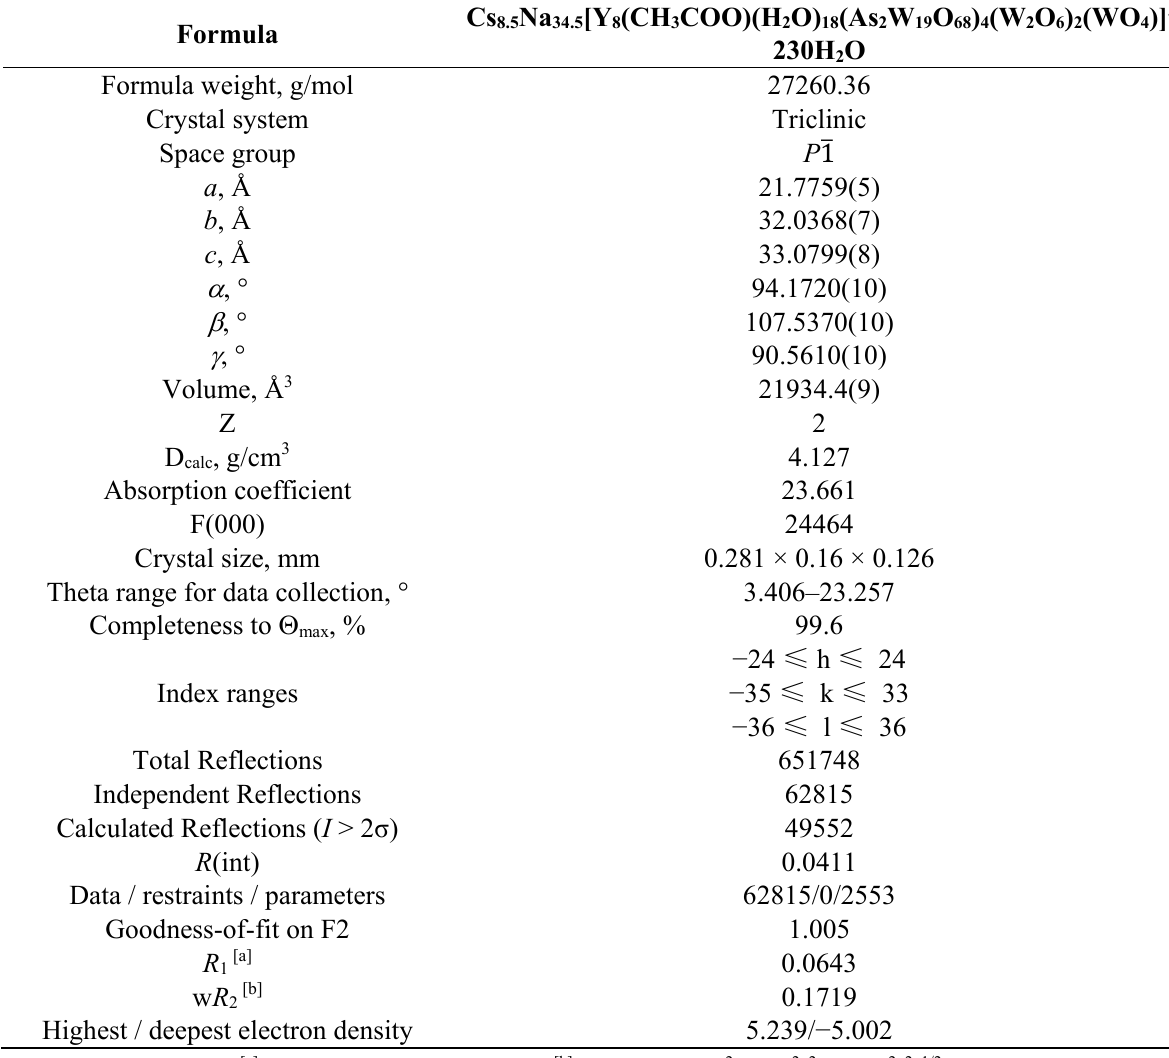
Table 1. Crystal Data for CsNa-1